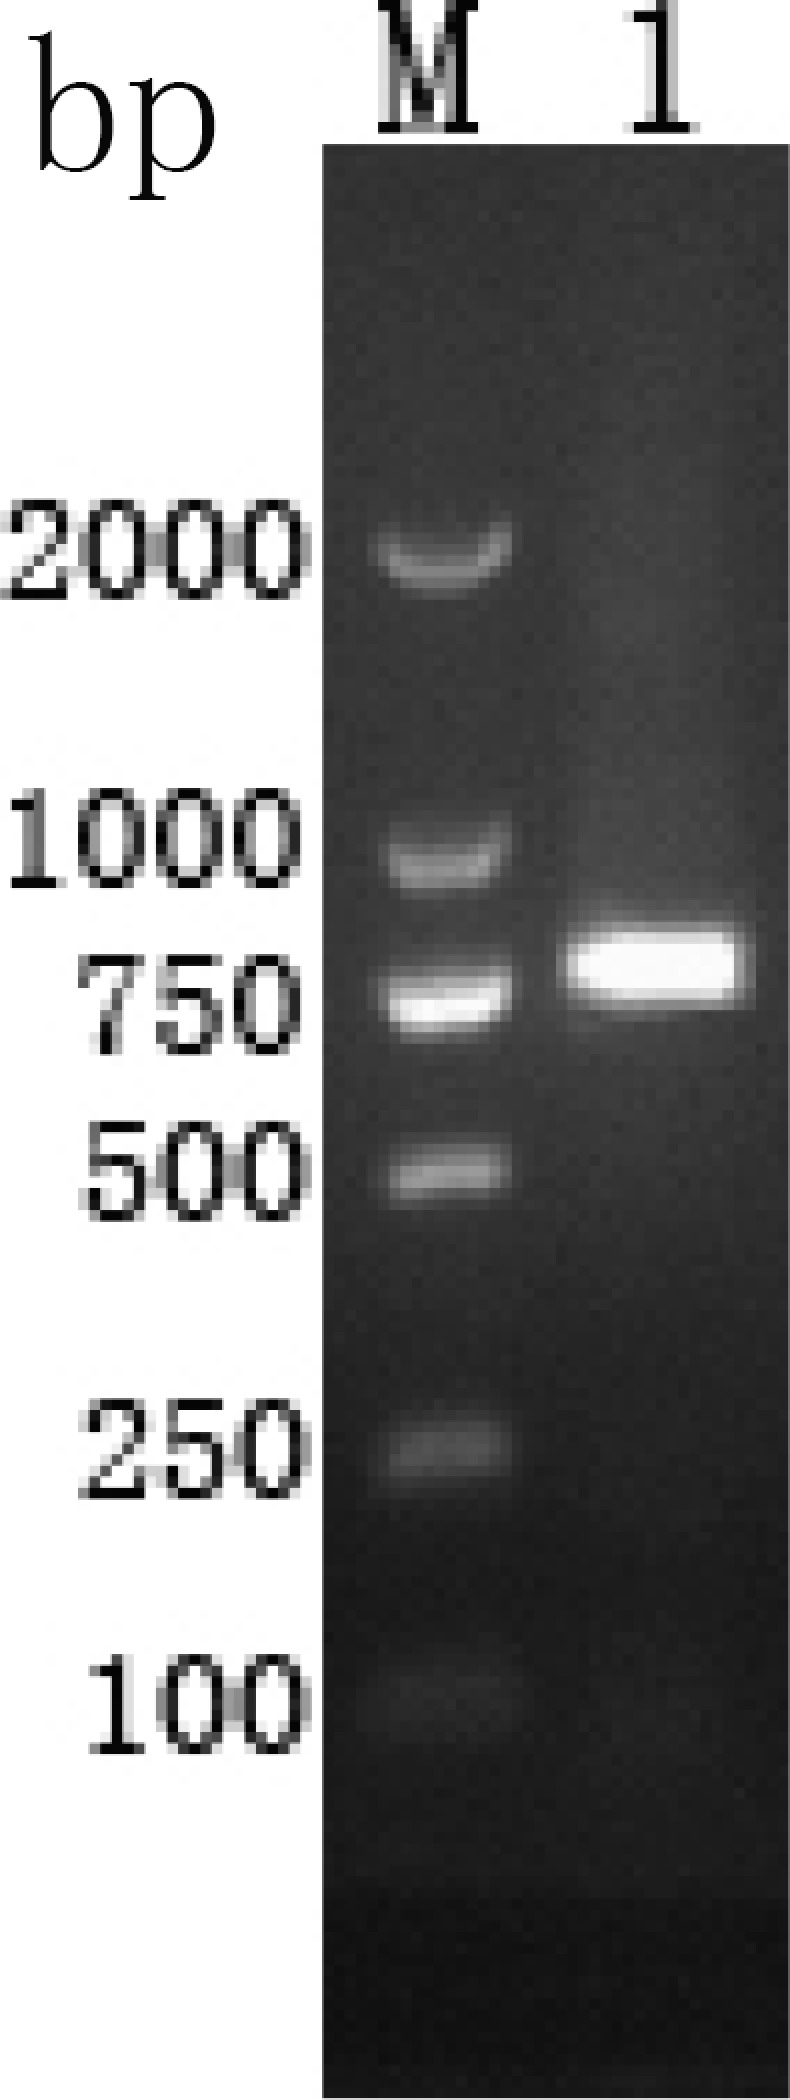
The ORF of EaMIC5 PCR.(Lane M) DNA Mark (ordinate values in bp); (Lane 1) the ORF of EaMIC5.